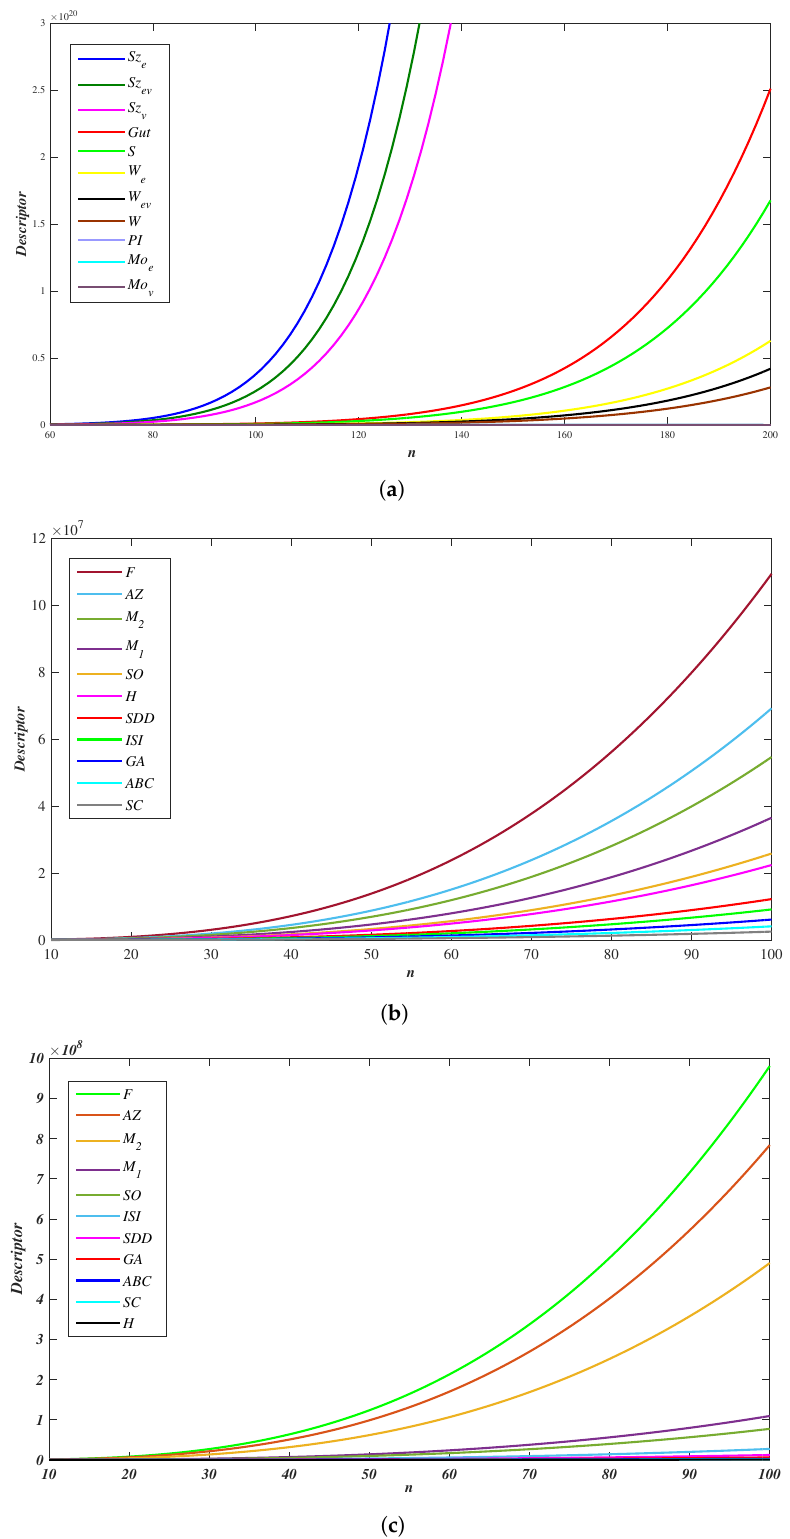
Figure 5. Comparative analysis of descriptors in WNR ( n , n , n ) ( a ) Distances ( b ) Degree ( c ) Degree-